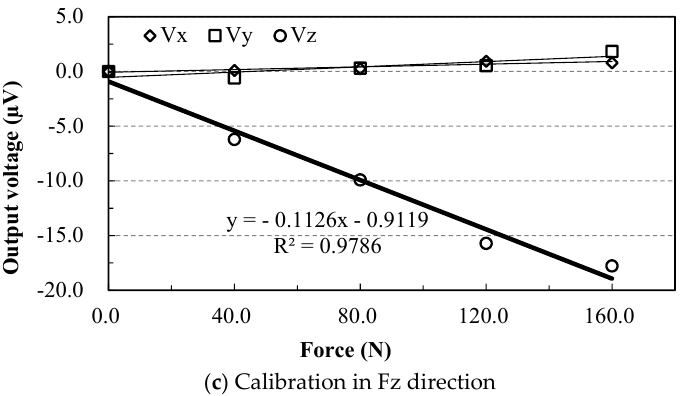
Figure 5. The Three-dimensional forces measurement through dynamometer in ( a ). F x , ( b ). F y, and ( c ). F z directions .